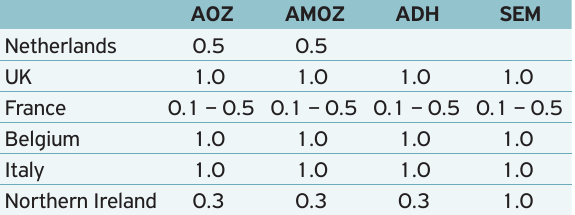
Table 3. Reporting limits of nitrofuran metabolites expressed in